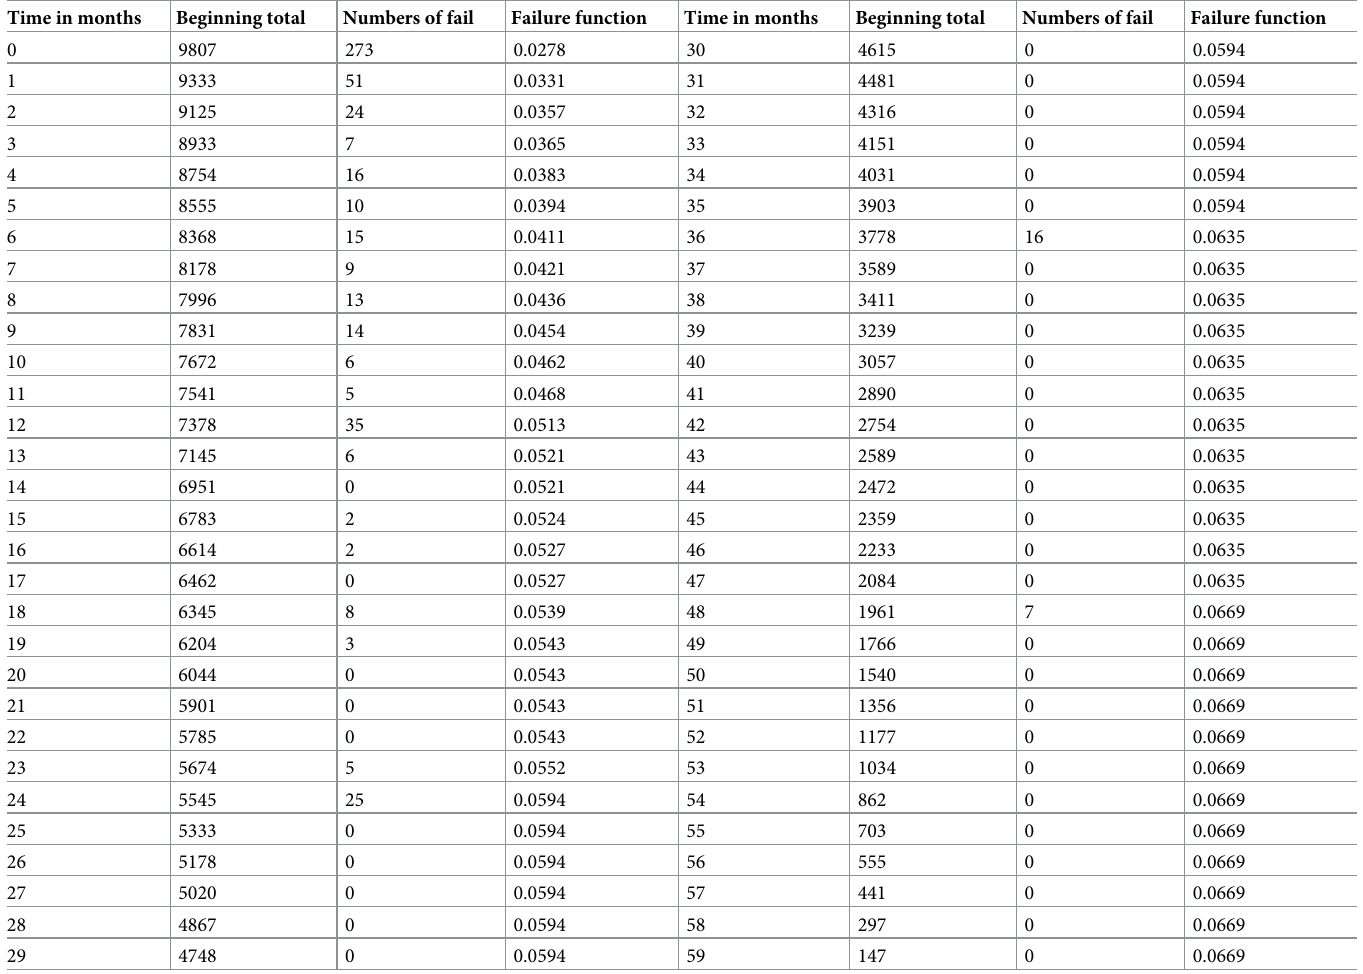
Table 3. A list of Kaplan-Meier estimates of the failure function (time to under-five mortality) in rural Ethiopian children under the age of